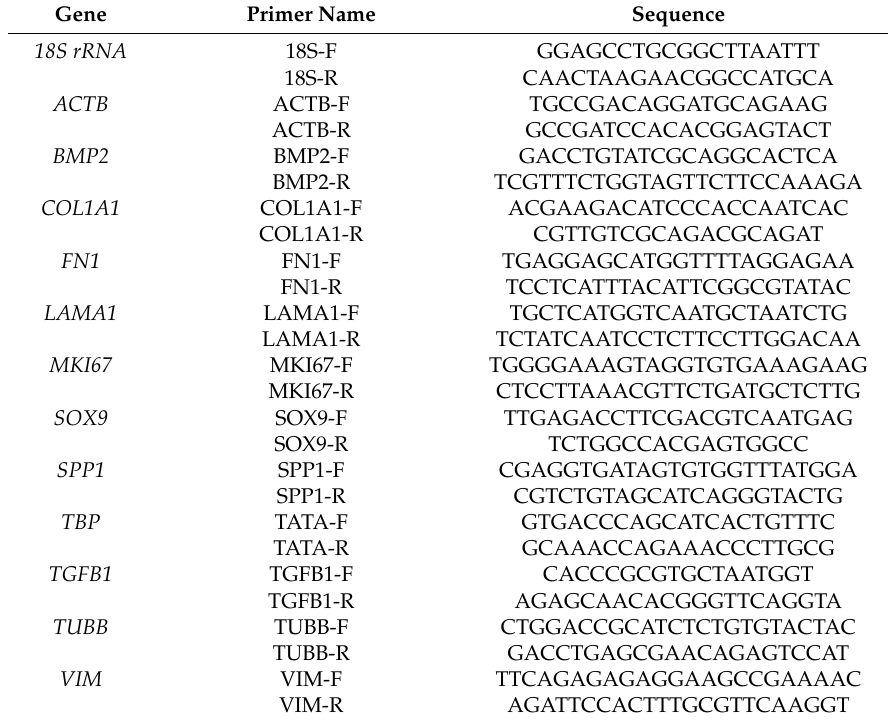
Table 2. Primers used for